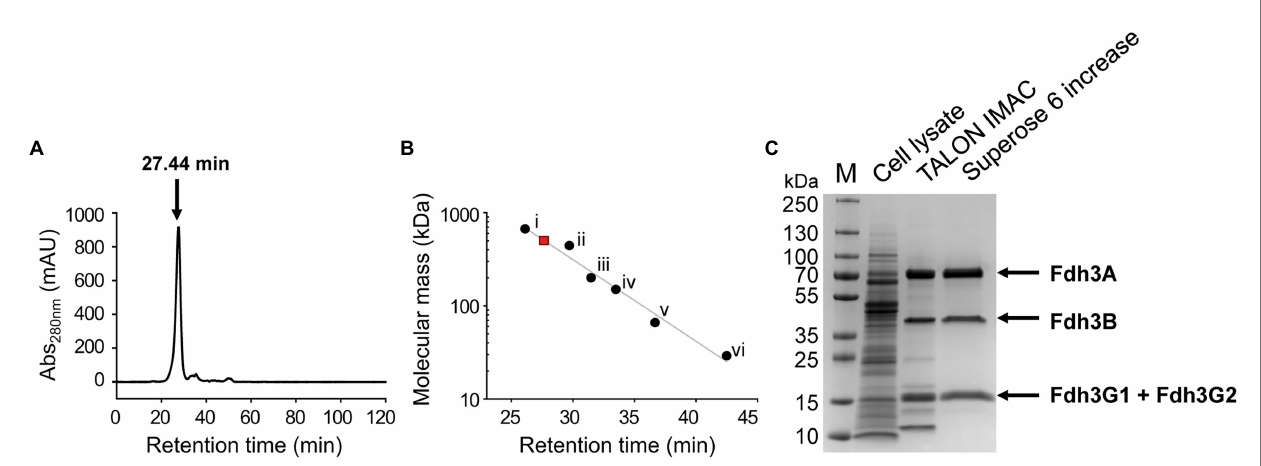
FIGURE 3 | Purification of Fdh3 proteins and SDS–PAGE analysis. (A) Elution profile of size exclusion chromatography. (B) Linear regression analysis between retention time and logarithm of molecular weight of protein standards ( r 2 = 0.975). Protein standards were as follows: (i) thyroglobulin (669 kDa), (ii) apoferritin (443 kDa), (iii) β -amlyase (200 kDa), (iv) alcohol dehydrogenase (150 kDa), (v) albumin (66 kDa), and (vi) carbonic anhydrase (29 kDa). The Fdh3 complex corresponding to a molecular mass of 524 kDa is indicated by a red square. (C) SDS–PAGE of protein samples at each purification step. Ten micrograms of cell lysate and 5 μ g of each of the protein samples from TALON IMAC and Superose 6 Increase were analyzed.